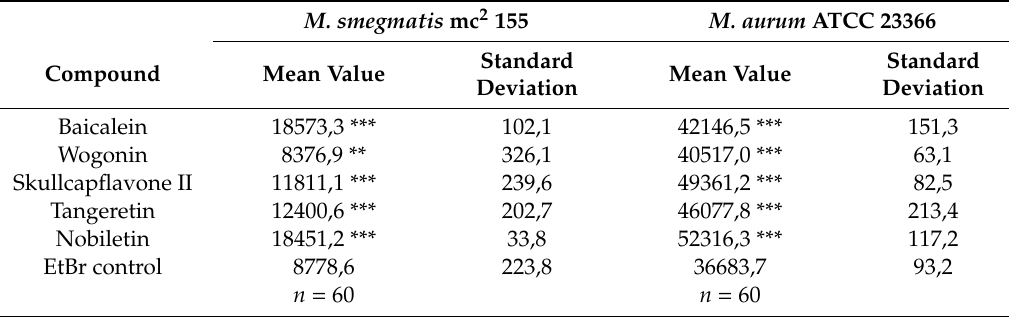
Table 3. Results of the relative fluorescence of